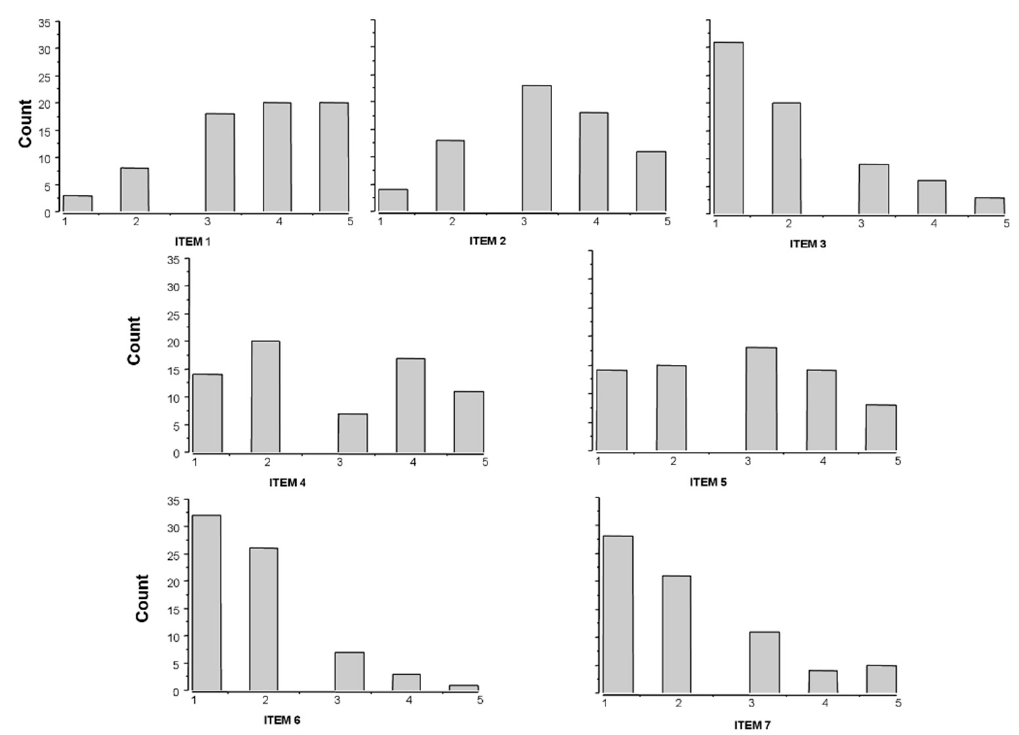
Int. J. Environ. Res. Public Health 2021 , 18 , x FOR PEER REVIEW Figure 1. Histograms of the seven items of the Fear of COVID questionnaire in the overall STEMI population.